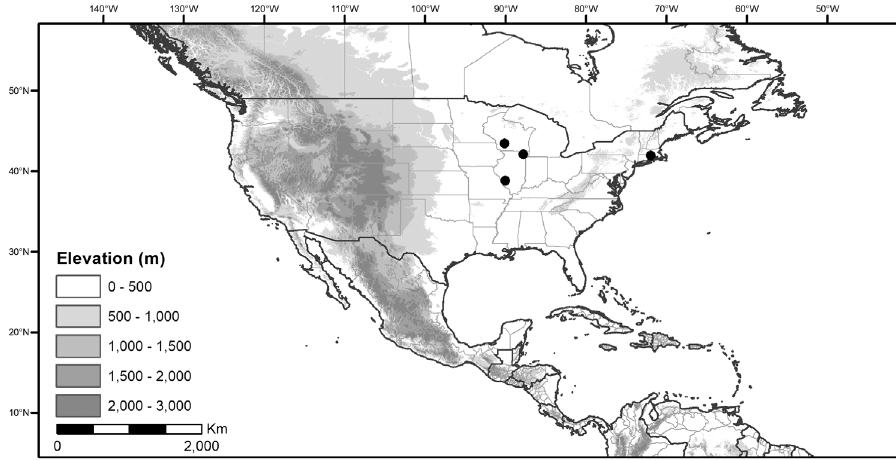
Figure 50. Distribution of Solanum scabrum Mill. (specimens mapped are all